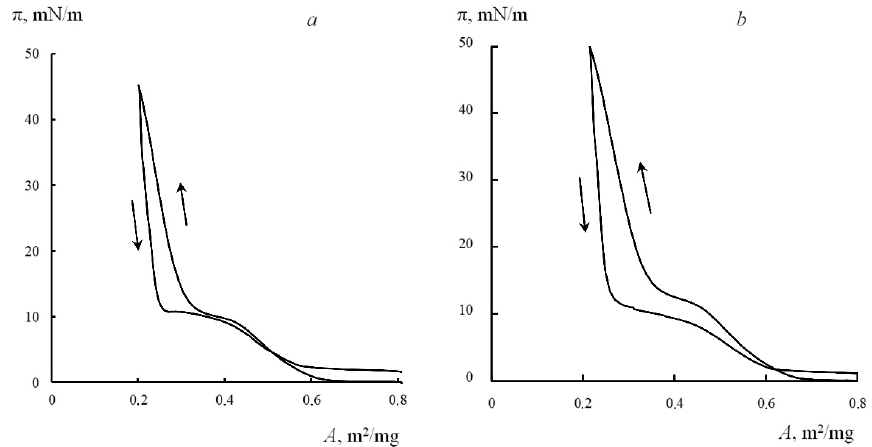
Figure 4. Compression–expansion curves of block copolymer PNIPAAm–Ge(C 6 F 5 ) 2 –PFMA mono- layers spread with chloroform/methanol at various pH = 7.0 ( a ) and 1.3 ( b ) (volume of spreading solution 30 μ L, T = 21 °C).